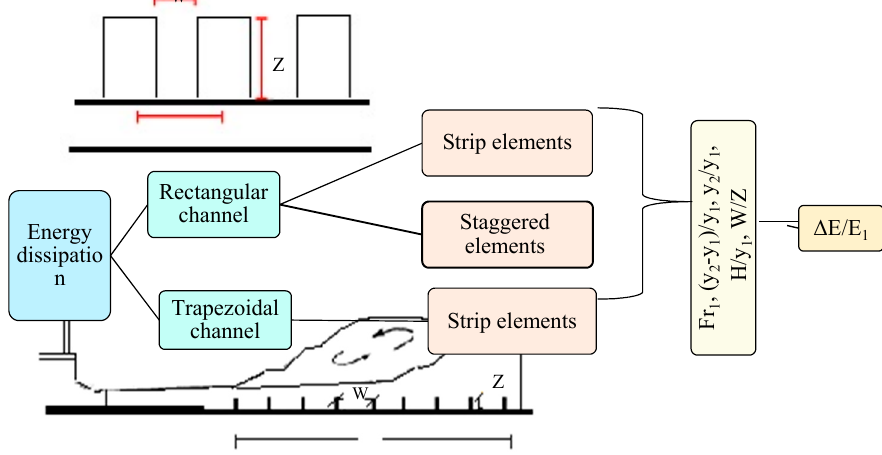
Figure 2. The schematic view of different types of channels used in this study.